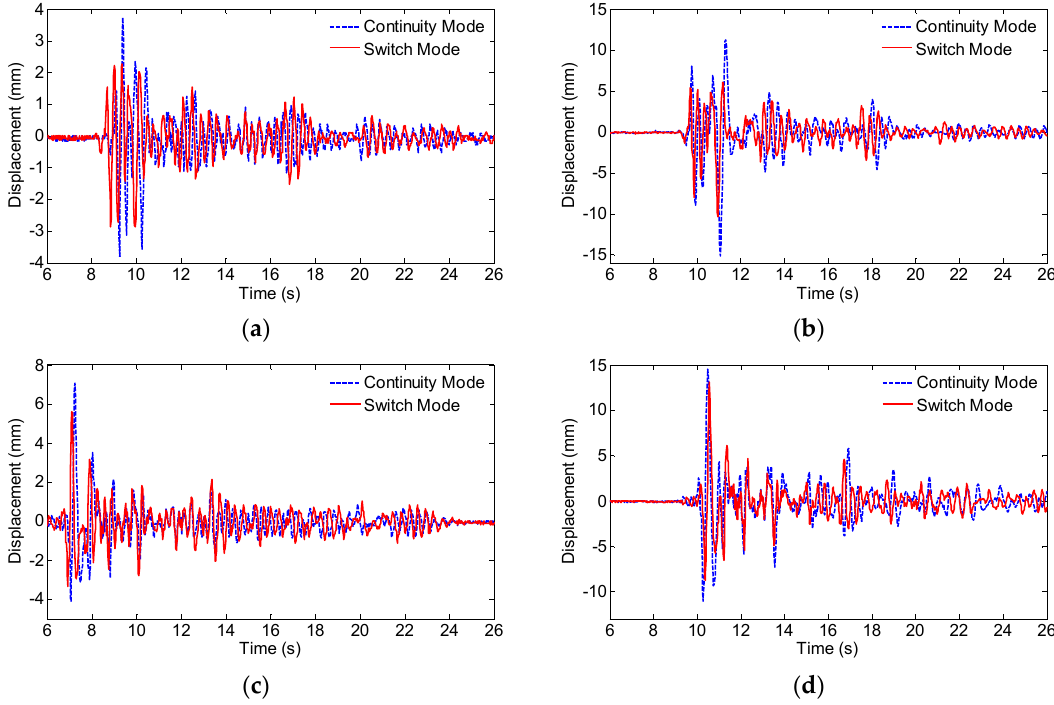
Figure 9. Displacement time history of isolation layer under two earthquake waves and control modes: ( a ) E1-Centro wave under fortification intensity; ( b ) E1-Centro wave under rare intensity; ( c ) Taft wave under fortification intensity; ( d ) Taft wave under rare intensity.